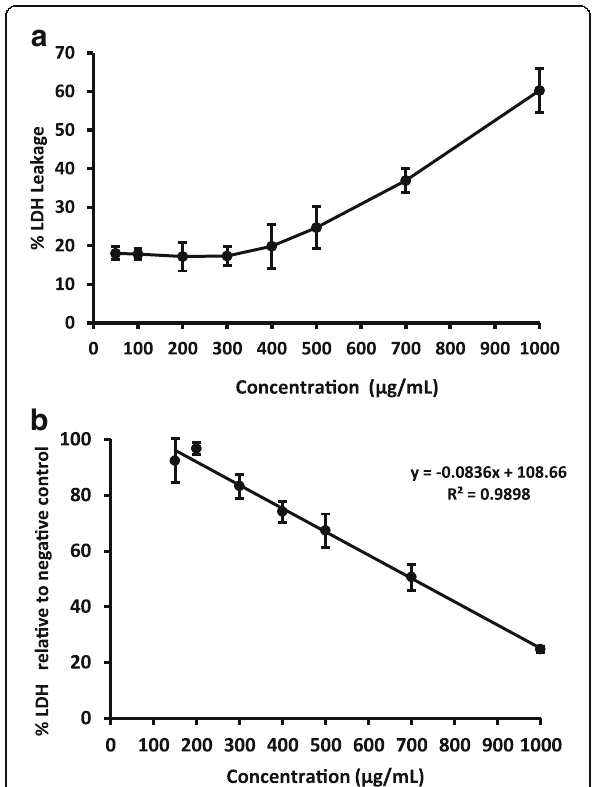
Fig. 3 a Percentage LDH leakage (Mean ± SD; n = 3) of HEp-2 cells after 24 hour exposure of Semecarpus parvifolia Thw. at different concentrations; b The percentage LDH activity of the cell lysate of the treated cells to that of the negative